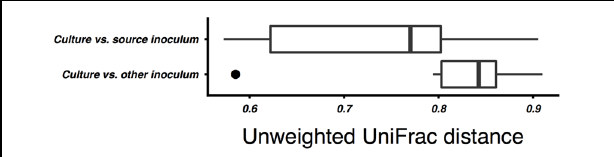
FIGURE 2 | Comparison of unweighted UniFrac distances between the bacterial communities of culture samples and the community of their source inoculum sludge vs. the non-source sludge. Unweighted UniFrac distances were calculated on OTU counts subsampled to even depth. The difference between groups was statistically significant (Mann–Whitney, p < 0.05).